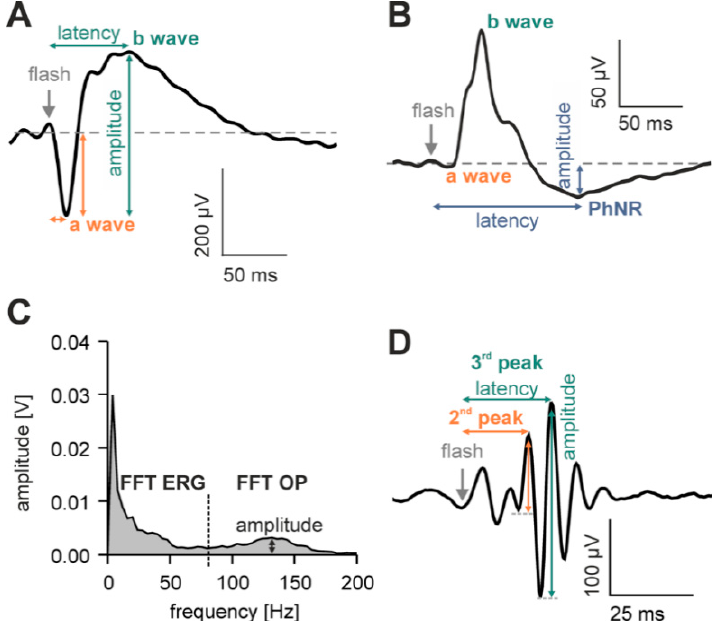
Figure 8. Analysis of the different flash ERG components. ( A ) Example of a scotopic flash ERG. The a-wave amplitude was defined as the absolute difference between the pre-stimulus baseline (horizontal dotted line) to the minimum of the a-wave. The difference between the a-wave trough and the peak of the b-wave was taken as the b-wave amplitude. The implicit times of the a- and b-waves were measured from the flash onset (vertical dashed line); ( B ) The photopic flash ERG contained the PhNR as a further component, in addition to the a- and the b-waves. The absolute difference between the pre-stimulus baseline and the minimum of the PhNR was taken as the PhNR amplitude; ( C ) The amplitude plot of the flash ERG in the frequency domain after the Fourier transform. The corresponding phase plot is not shown. The signal is built from a low frequency portion, containing the conventional ERG without OPs and a high frequency portion containing the OPs; ( D ) OPs in the time domain are obtained by an inverse Fourier transform of the high frequency portion. For a more detailed exploration of the OPs, the amplitudes and implicit times of the second and third OP peak were also analyzed. The differences between the second or third peak and the previous trough were taken as amplitudes of the second or third OP peak, respectively.